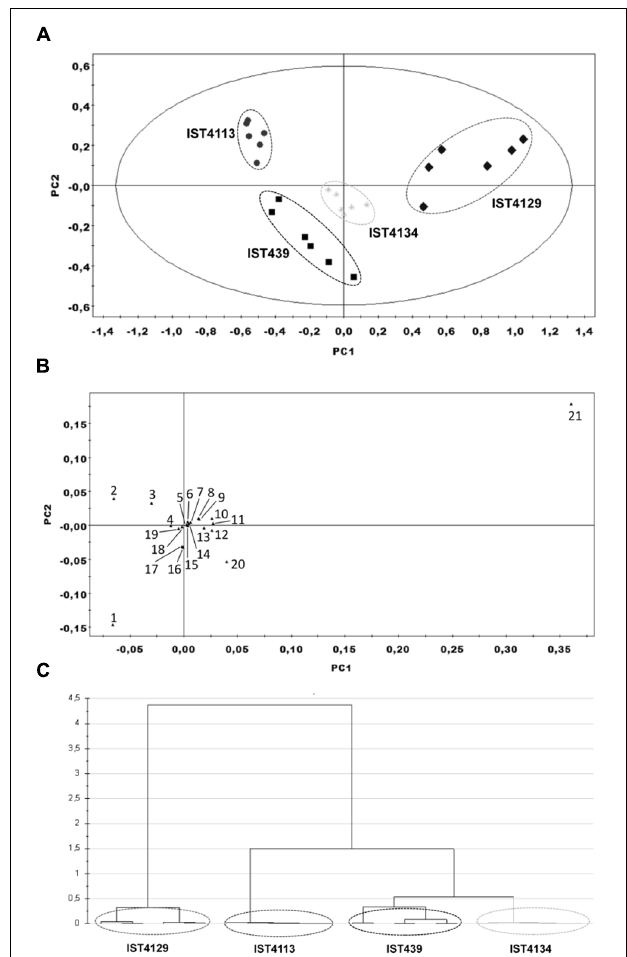
FIGURE 2 | Endometabolome multivariate analysis of four B. cenocepacia sequential clonal variants retrieved from a CF patient chronically infected for 3.5 years. (A) 2D score plot displaying the space formed by the two first principal components (R 2 X for PC1 equal to 0.693 and R 2 X for PC2 equal to 0.139), (B) 2D loading plot displaying the space formed by the two first principal components and displaying the characteristic bins for a set of metabolites, and (C) dendrogram based on the PCA scores (ward clustering distance measure) considering all principal components of the model. For the 2D score plot shown in (A) , each point represents a spectra obtained for independent samples, resulting in six samples for each isolate. Key : (1) Trehalose, (2) Glycine, (3) L -serine, (4) Glucose, (5) Uracil, (6) Fumarate, (7) L -aspartic acid, (8) Oxidized glutathione, (9) AMP, (10) L